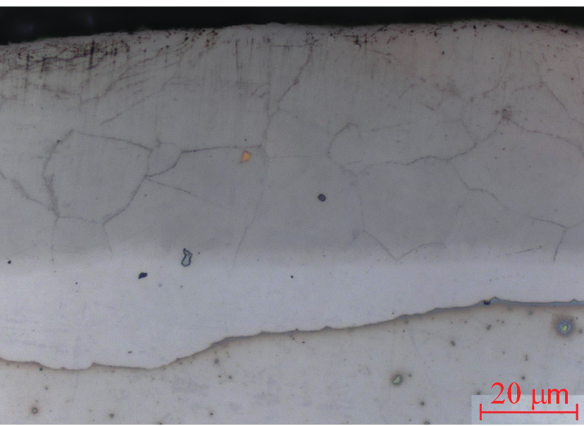
Figure 8: Cross-section of a nitrided sample, treatment time 60 min Nitriding temperature 625°C, sample bias – 750 V, sample current density 3.3 mA/cm 2 , layer microhardness 12.0 GPa.